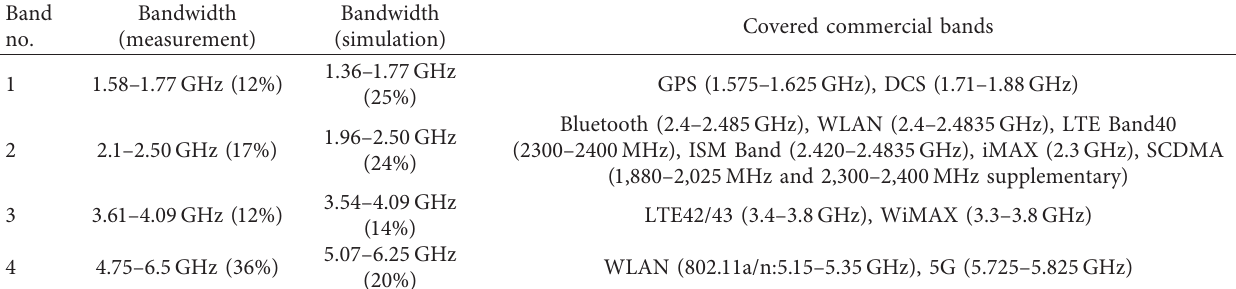
Table 4: Simulated and measured frequency bands covered by the